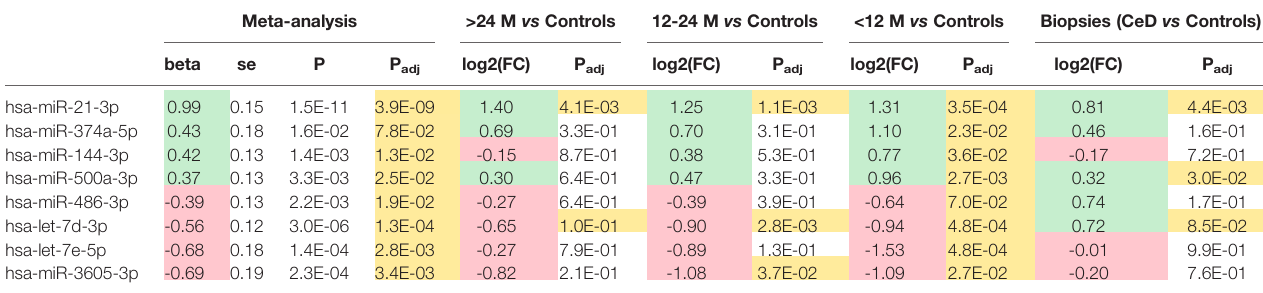
TABLE 2 | Of the 53 circulating miRNA biomarker candidates for CeD development identi fi ed in the meta-analysis ( Figure 2 ), these eight miRNAs were signi fi cantly different in samples taken <12 months before diagnosis. Meta-analysis >24 M vs Controls 12-24 M vs Controls <12 M vs Controls Biopsies (CeD vs